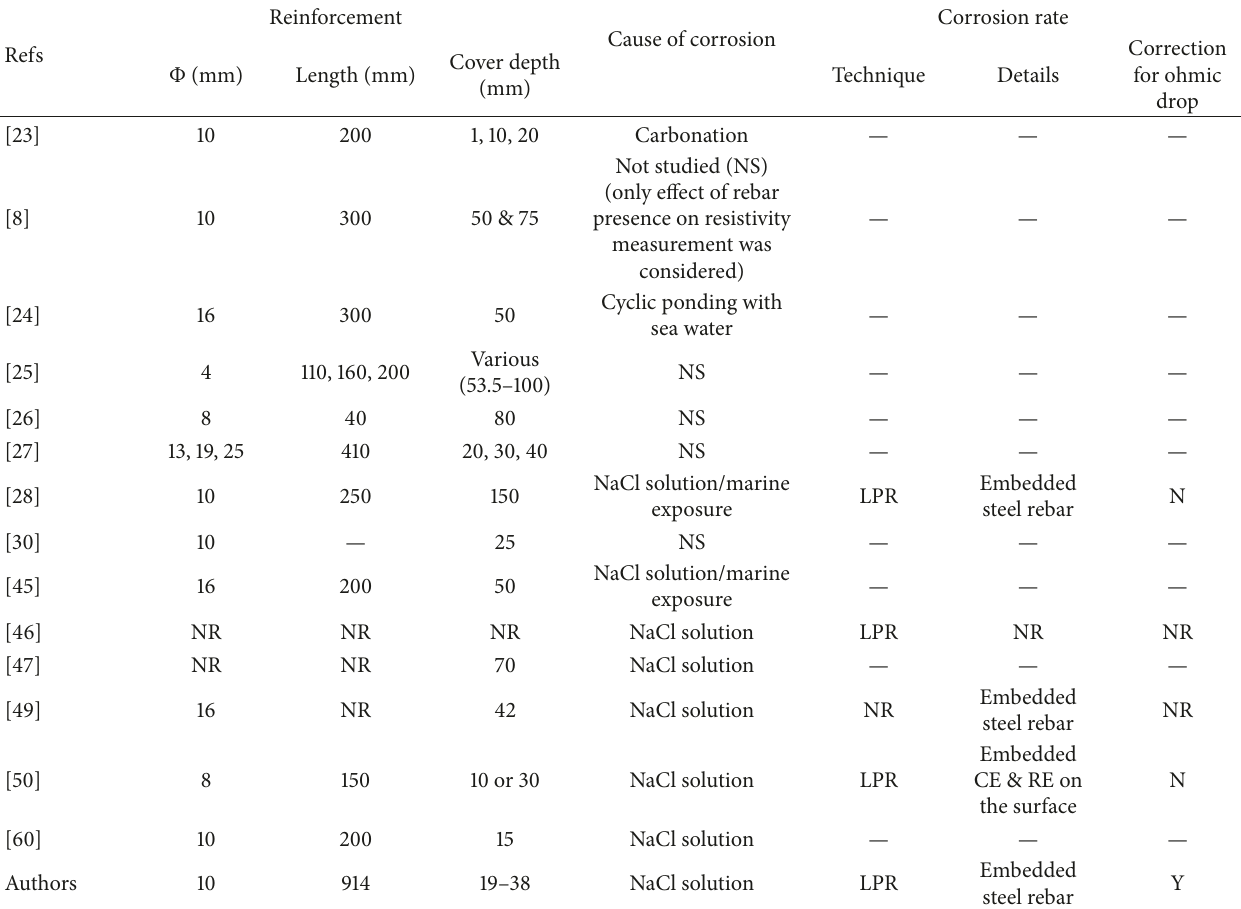
Table 2: Details of the reinforcements and measurement methods used to record corrosion